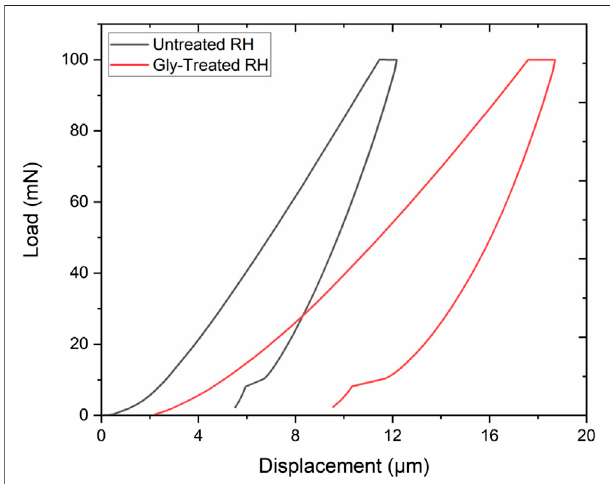
FIGURE 3 | Load displacement compliance curves of untreated and aqueousglycerol (75 wt%) treated RH at 100 mN nominallyspacing of60 µm between each